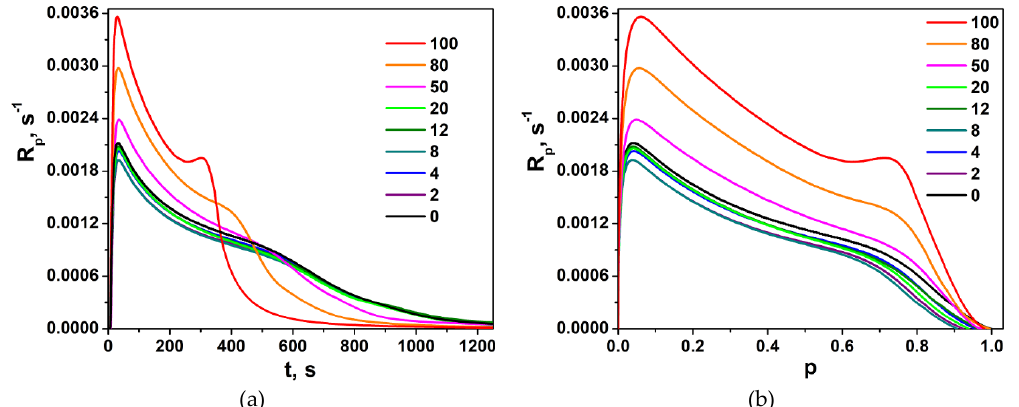
Figure 6. Polymerization rate, R p , of LM/TSM compositions as a function of ( a ) the irradiation time, t , and ( b ) double bond conversion, p , at 40 °C. The numbers indicate the TSM content (mol %) in the mixture.